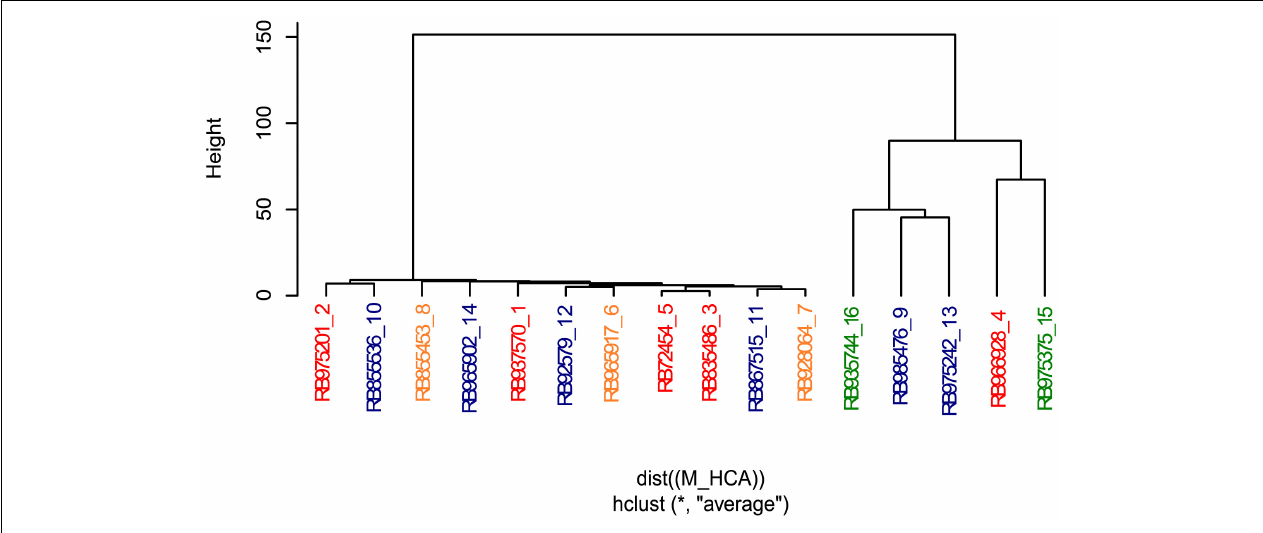
FIGURE 5 | Hierarchical cluster analysis revealed that metabolite profiling from culms discriminates sugarcane commercial cultivars. Genotypes are color-coded as follows: red, orange, blue, and green represent low, intermediate-low, intermediate-high, and high sprouting groups,